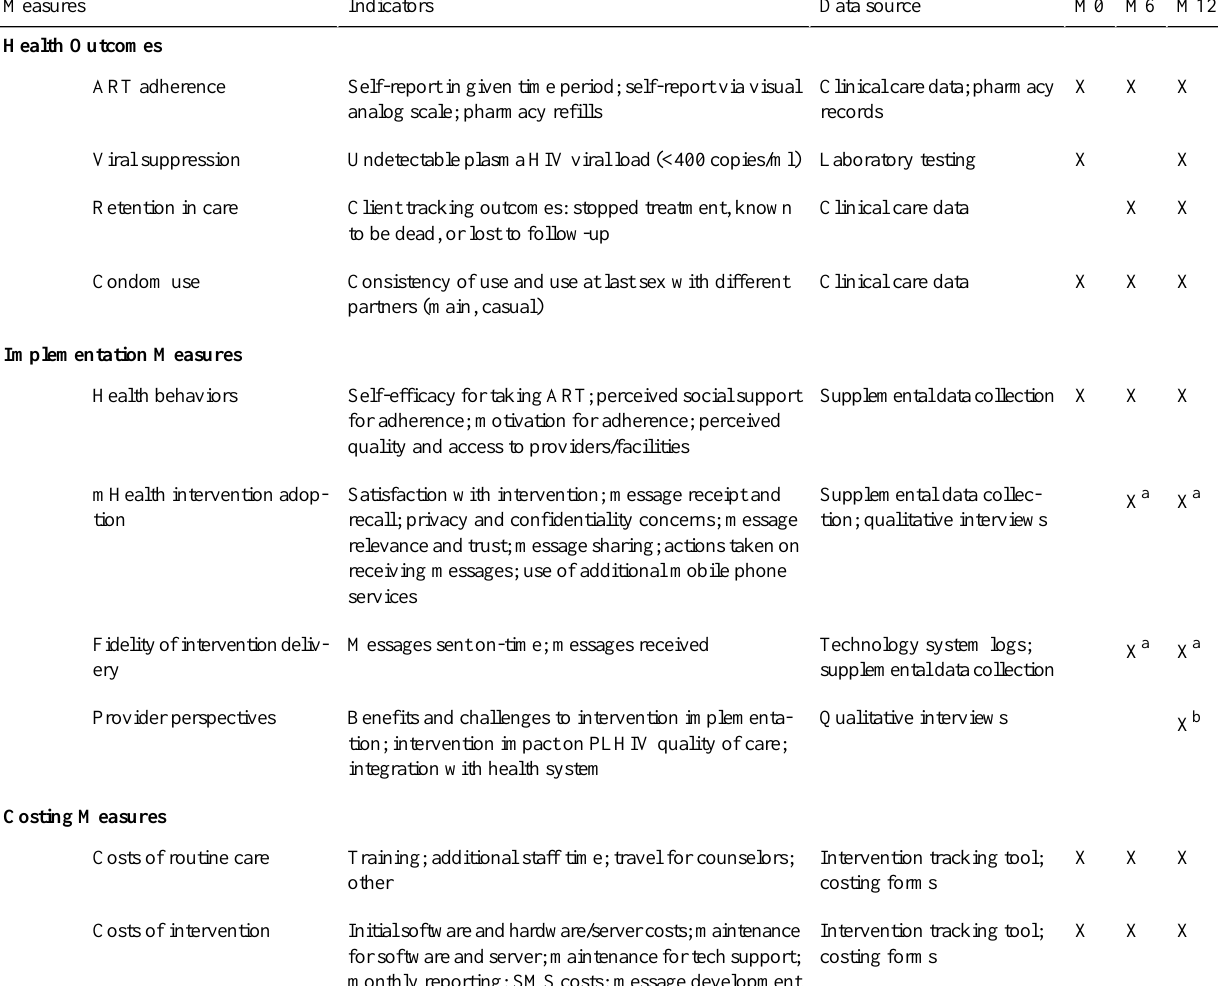
Table 1. Overview of